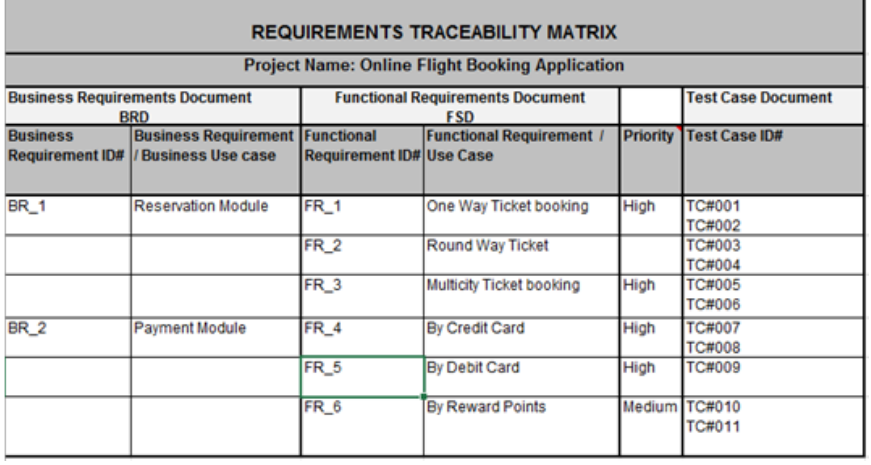
Fig. 2. Example of simple Requirements Traceability Matrix (RTM), (Opencodez